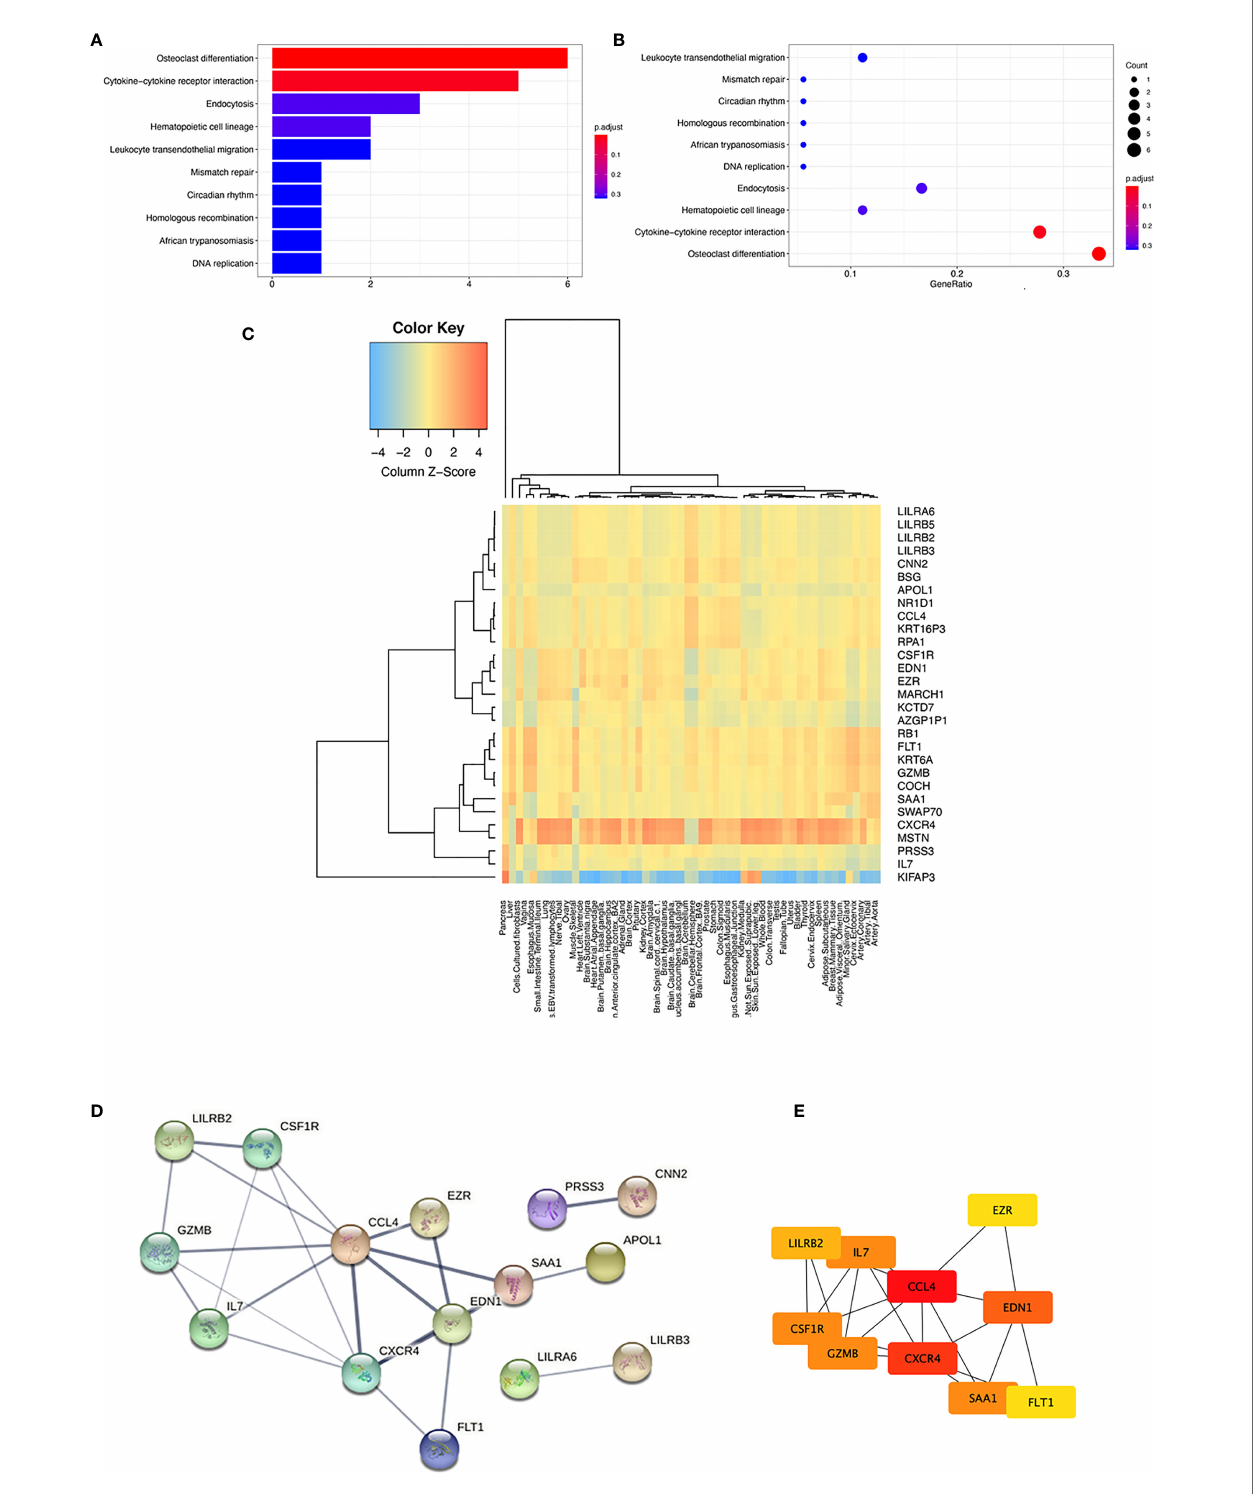
FIGURE 2 | KEGG pathway analysis and expression characteristics of 30 immune-related candidate genes. (A) Bar plot of the KEGG pathway enrichment (B) Dot plot of the KEGG pathway enrichment (C) Organ and tissue expression characteristics analyzed by GTEx. A heatmap of the tissue-speci fi c gene expression for 30 immune-related candidate genes in different organs and whole blood from the genotype-tissue expression project (GTEx) v8 54 tissue types of dataset. (D) PPI network of the 30 immune- related candidate genes and three modules were clustered by the STRING database. (E) PPI network of the top 10 hub genes of the 30 immune-related candidate